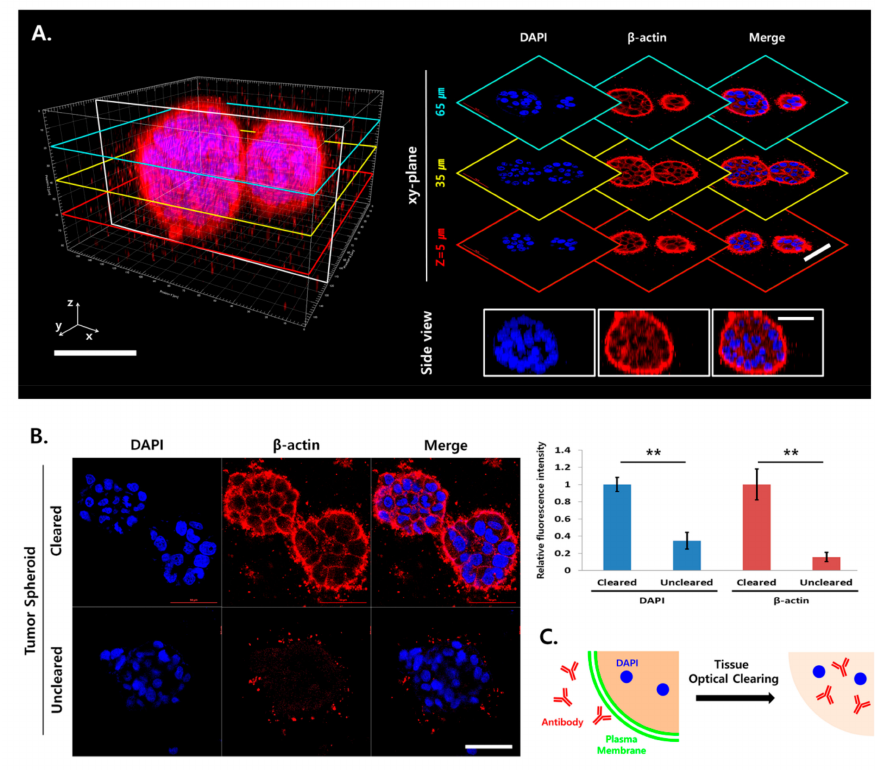
Figure 3. Improved penetration of immunolabeling antibodies and light transmission in Capan-1 tumor spheroids (TSs) after tissue optical clearing (TOC). ( A ) Three-dimensional (3D) confocal images of a single Capan-1 TS stained with β -actin (red) and DAPI (blue). Optical sections were obtained at 5- µ m increments along the z -axis for 3D reconstruction. ( B ) Increased fluorescence intensity of β -actin (red) and DAPI (blue) in optical section images of TS shown in cleared samples. ( C ) Schematic illustration of improved penetration of immunolabeling antibodies in TS following lipid extraction during TOC. Data represent the mean ± SD of three independent experiments. ** p < 0.01. Scale bars: 50 µ